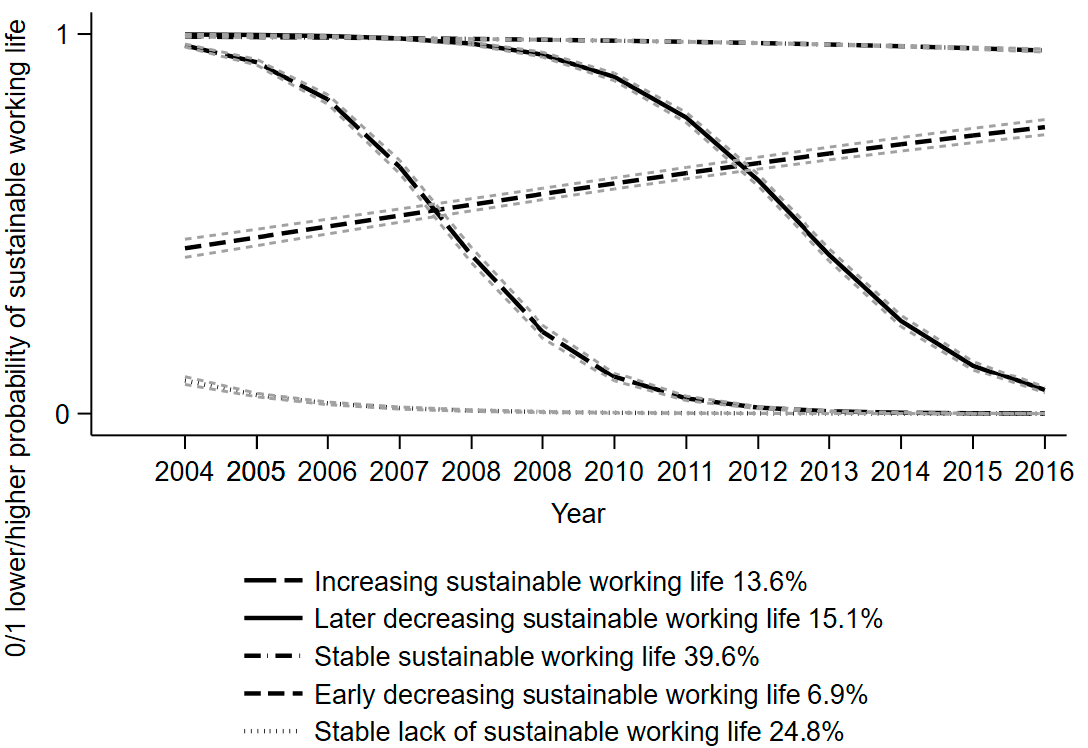
Figure 2. Trajectories of sustainable working life in the SALT cohort from 2004 to 2016. In the figure, some of the 95% confidence intervals are very narrow and almost invisible.